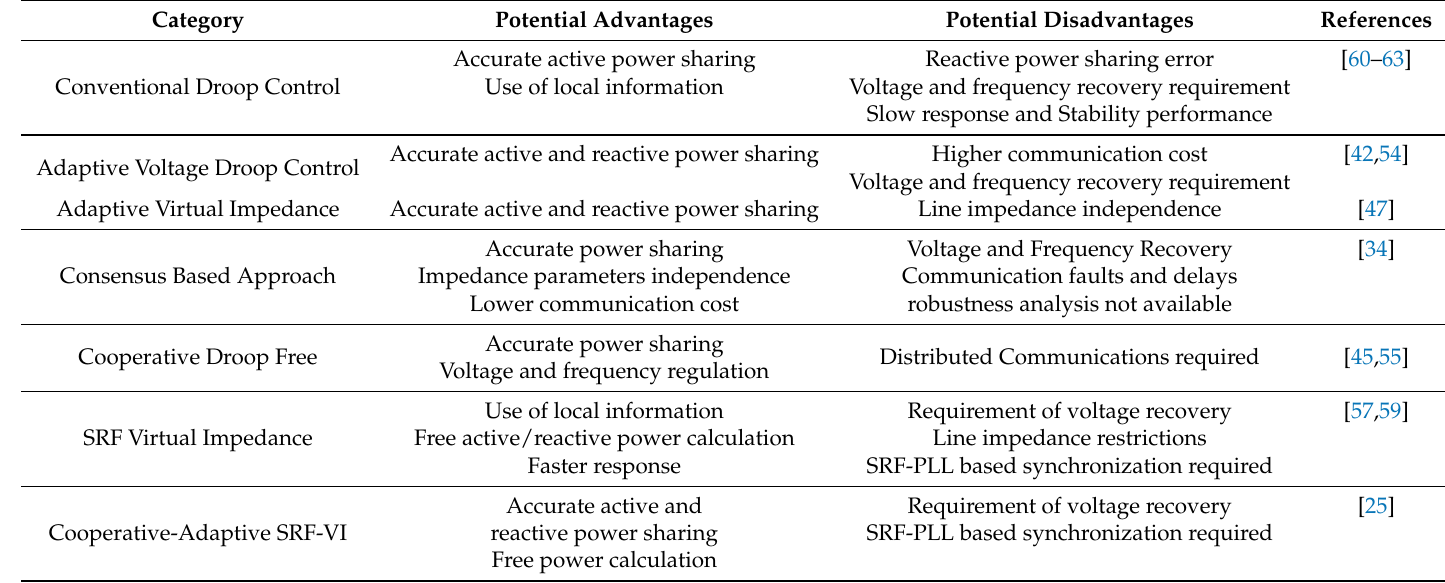
Table 2. Power sharing control strategies